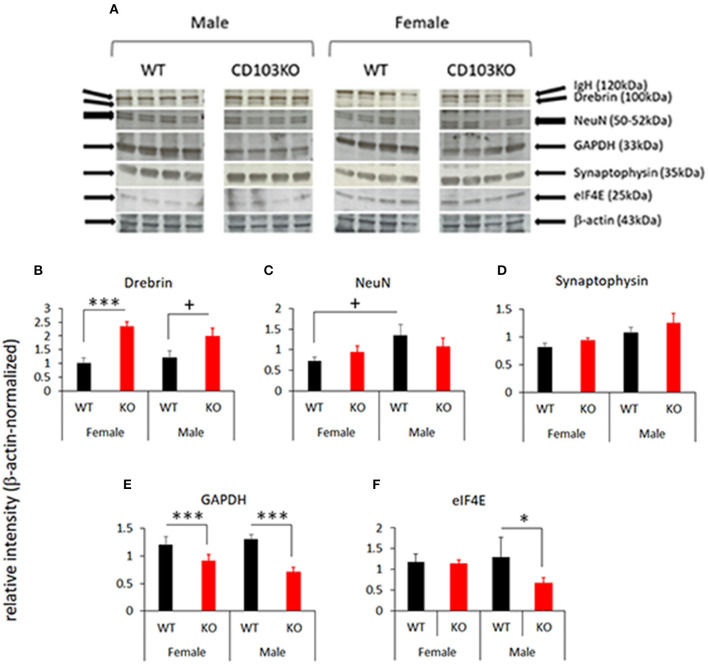
Selected protein markers in female and male CD103-deficient brain. Female and male forebrain from WT and CD103KO mice was homogenized and lysed in detergent, run on SDS PAGE gels, blotted and probed with the indicated antibodies (A). Relative signal was normalized to β-actin in the same gel/blot lane, and results compiled from >4 animals per sex per strain. +P < 0.1 by 1-sided Mann Whitney test for male Drebrin (due to non-normal distribution/P < 0.05 in Shapiro-Wilk test; B); *P < 0.05, ***P < 0.005 by 2- sided T-Test for NeuN (C), Synaptophysin (D), GAPDH (E), and eIF4E (F), which all had normal distribution/P > 0.05 of data verified in Shapiro-Wilk test.